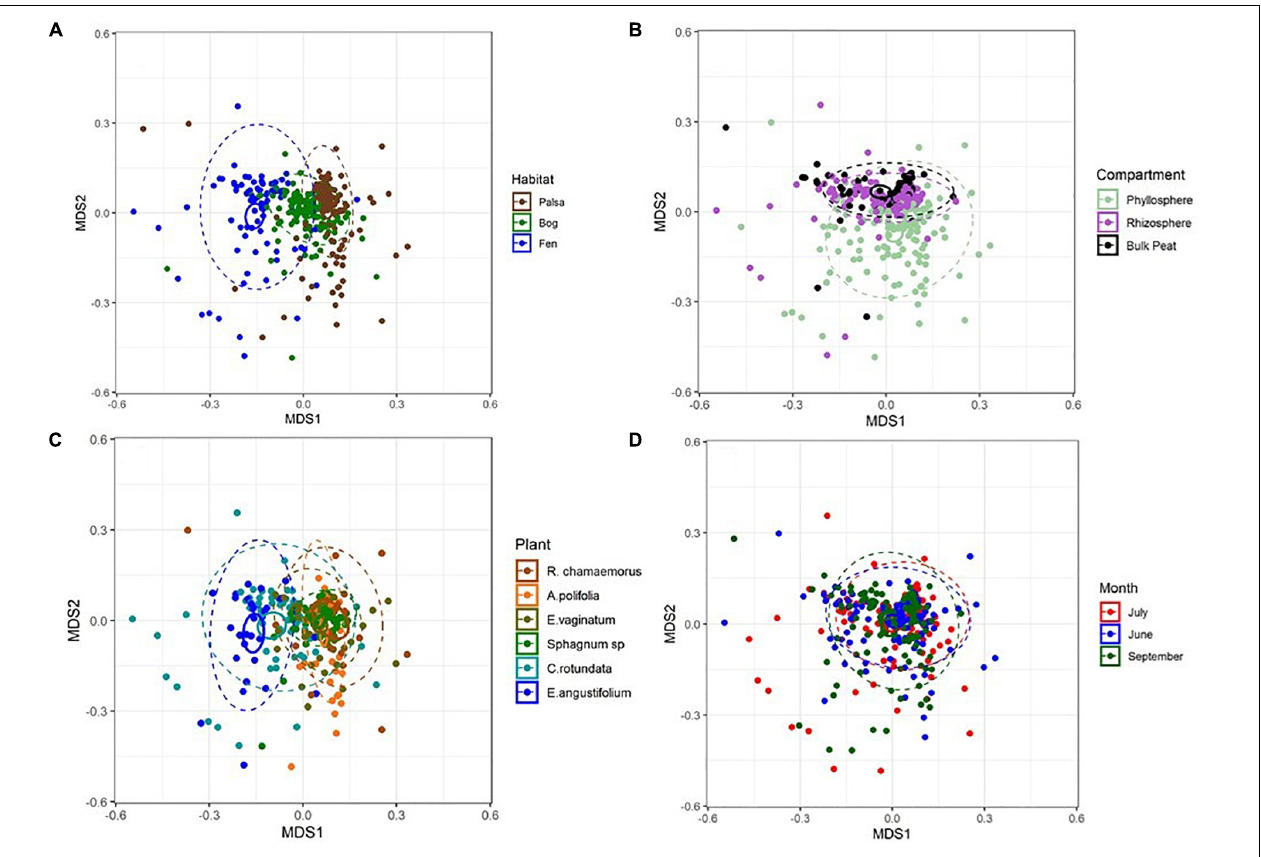
FIGURE 3 | NMDS plots of Bray–Curtis distances between samples from each (A) habitat, (B) compartment, (C) plant associate, and (D) month. Outer ellipses include 95% of points for a habitat, inner ellipses are 95% confidence around the centroid. Stress = 0.17. TABLE 1 | Variance explained by each factor based on Bray–Curtis and Unifrac distances of total dataset and Bray–Curtis distances of only OTUs included in networks. All OTUs OTUs in